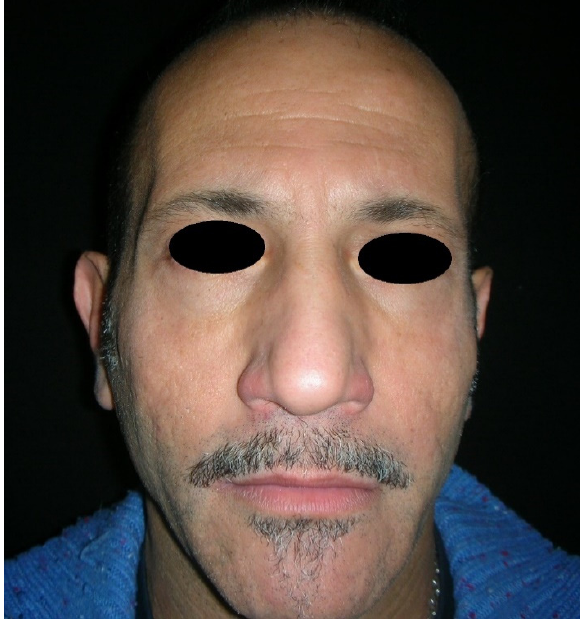
Figure 3. Frontal view of a patient presenting facial wasting (the same patient shown in Figure 1) treated with polyacrylamide hydrogel filler, at 2 years follow-up.